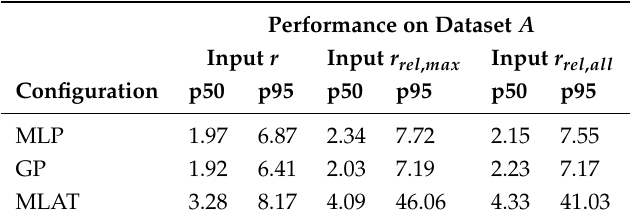
Table 4. The p50 and p95 errors expressed in (cm) for the evaluated schemes on dataset A . Performance on Dataset A